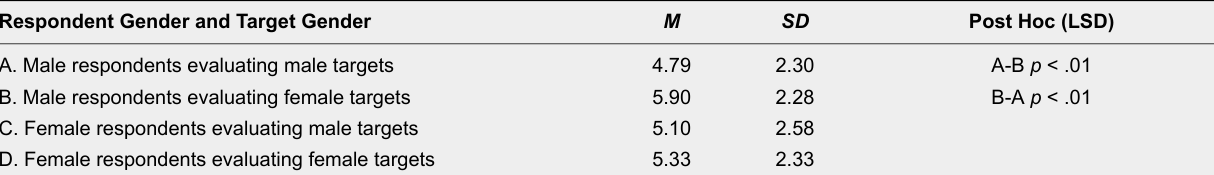
Perceived Conscientiousness: Simple-Effects Comparisons for the Interaction of Respondent Gender and Target